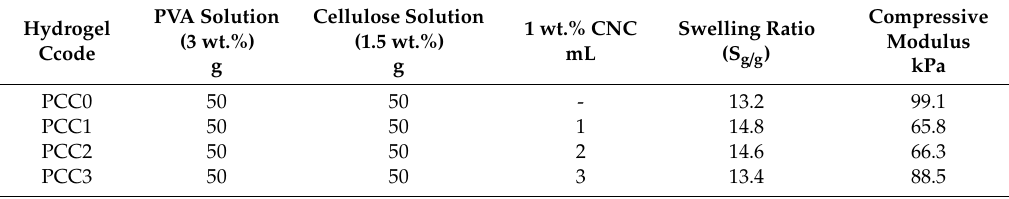
Table 1. Feed composition and properties of CNC-reinforced PVA-Cell